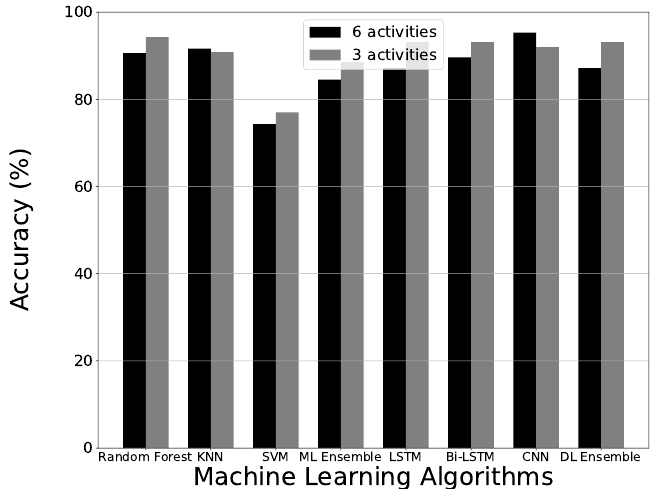
Figure 10. Ablation study results using data augmentation paired with